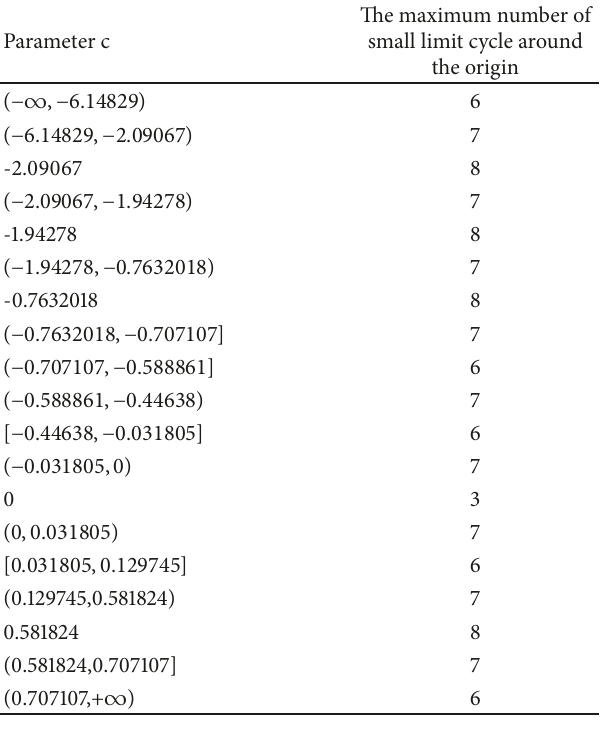
If 𝐹 3 (𝑐)𝐹 4 (𝑐) ≤ 0 , there exist 6 limit